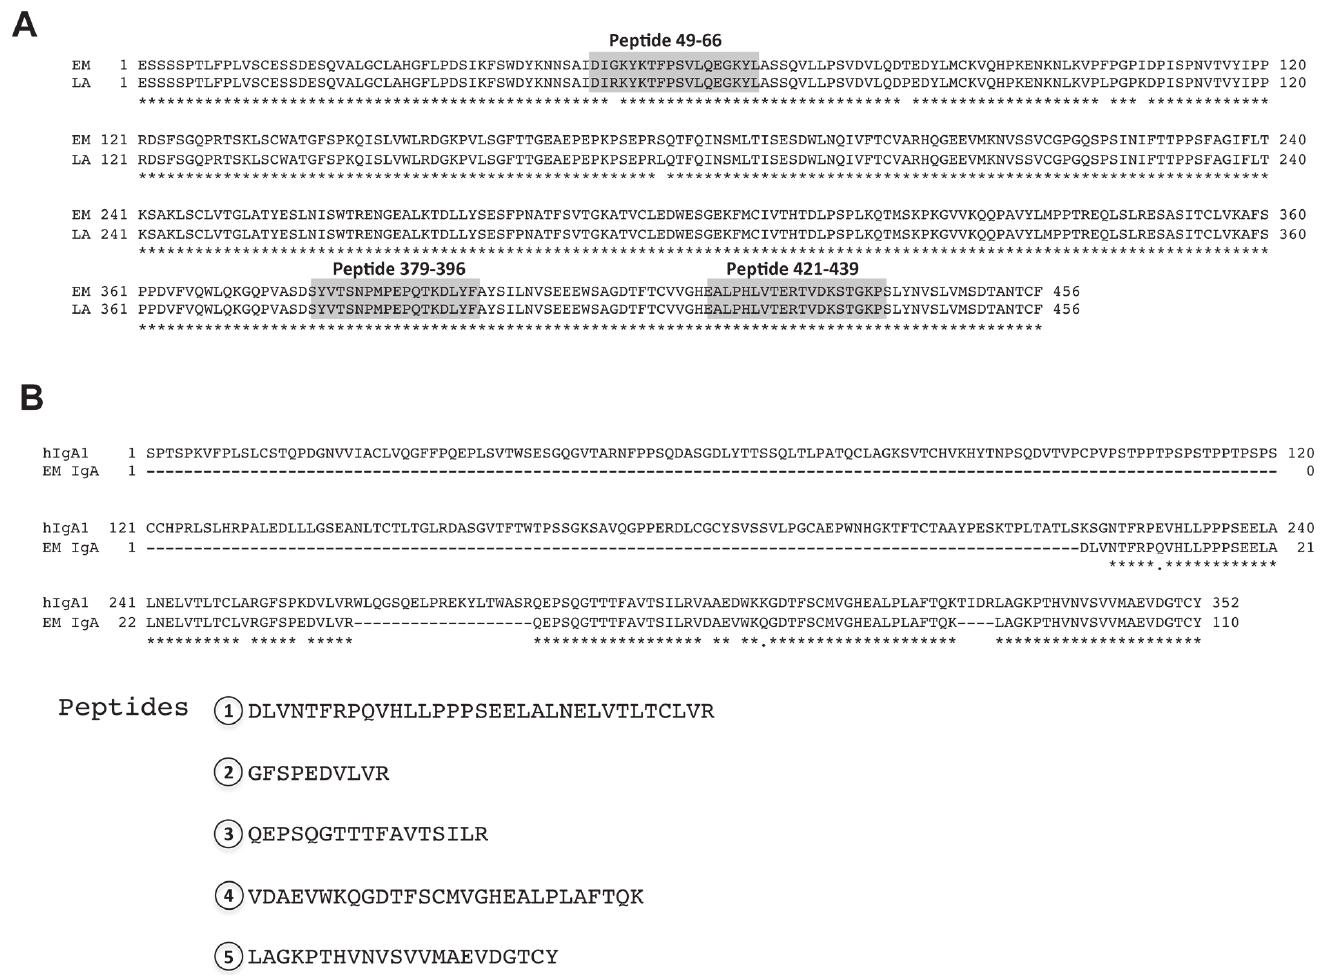
Fig 1. Predicted amino acid sequence of African savanna elephant and Asian elephant IgM and partial sequence of Asian elephant IgA. A) Alignment of Asian elephant (EM) and African savanna elephant (LA) IgM heavy chain constant region amino acid sequences (CH1 – 4) predicted from genomic sequencing. Peptide sequences used to generate elephant specific anti-IGM antibodies are shown outlined in grey shading. B) Alignment of human (hIgA1) and partially determined Asian elephant IgA protein sequences that were assembled from 5 peptides. Following tandem mass spectrometry analysis of a partially purified Asian elephant IgA, five peptides were identified and are listed below the aligned sequences.